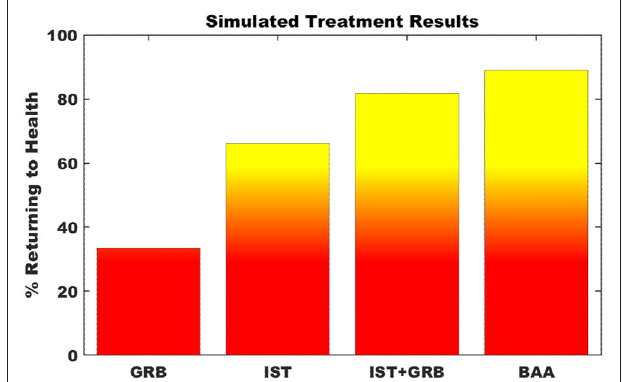
FIGURE 5 | Simulation of putative treatment strategies . Percent of Monte Carlo simulations of putative treatment strategies that return the neuroimmune system to typically healthy regulation. GRB—glucocorticoid receptor blockade; IST—immunosuppressive therapy; BAA—broad acting anti-inflammatory. Transition to yellow indicates point of greater than 50% of trials returning to